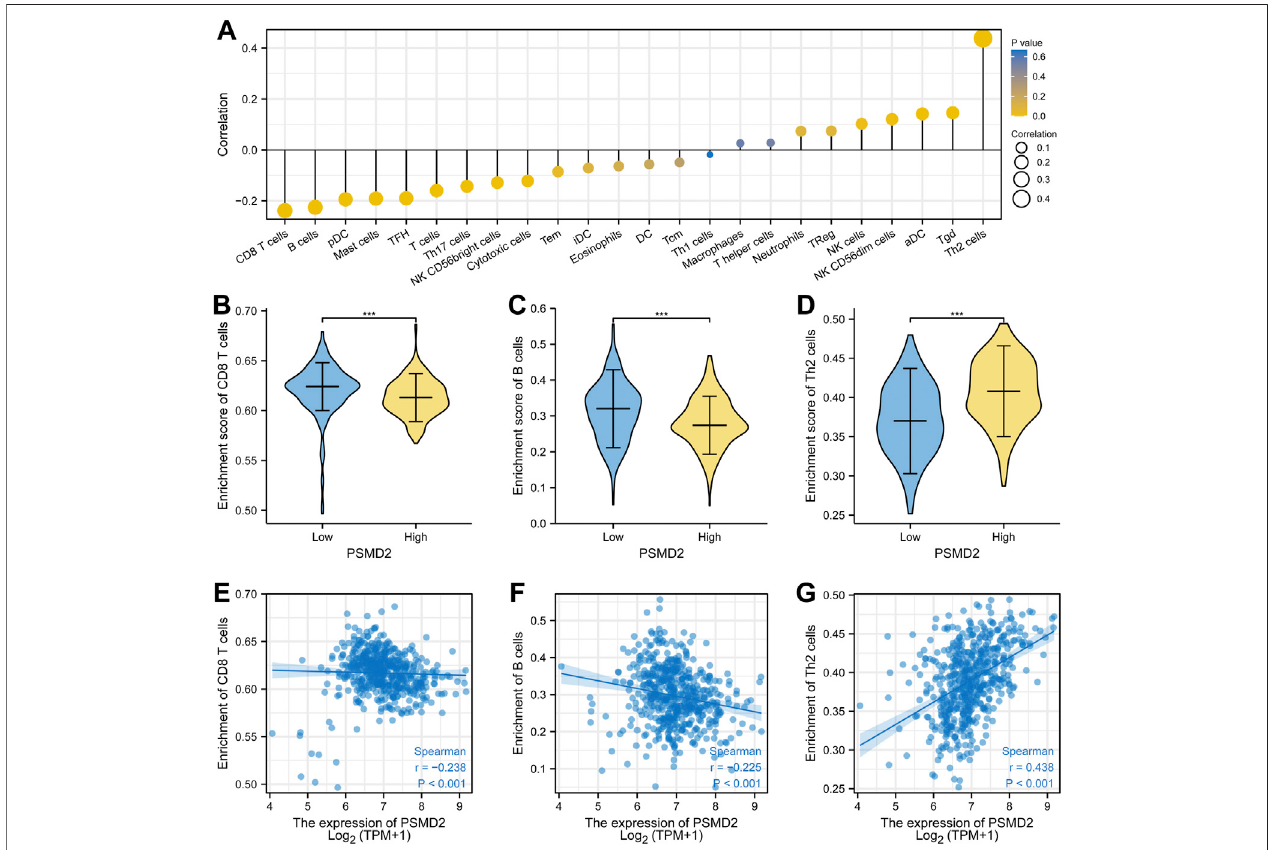
FIGURE 9 | Spearman correlation between PSMD2 expression and immune cell in fi ltration. (A) The correlation between PSMD2 expression and the relative abundances of 24 immune cells. (B – D) Mann-Whitney U test indicated there were differences in immune cells (CD8 T cells, B cells, Th2 cells) between high/low expression of PSMD2 . (E – G) Scatter diagrams for correlation between immune cells (CD8 T cells, B cells, Th2 cells) and PSMD2